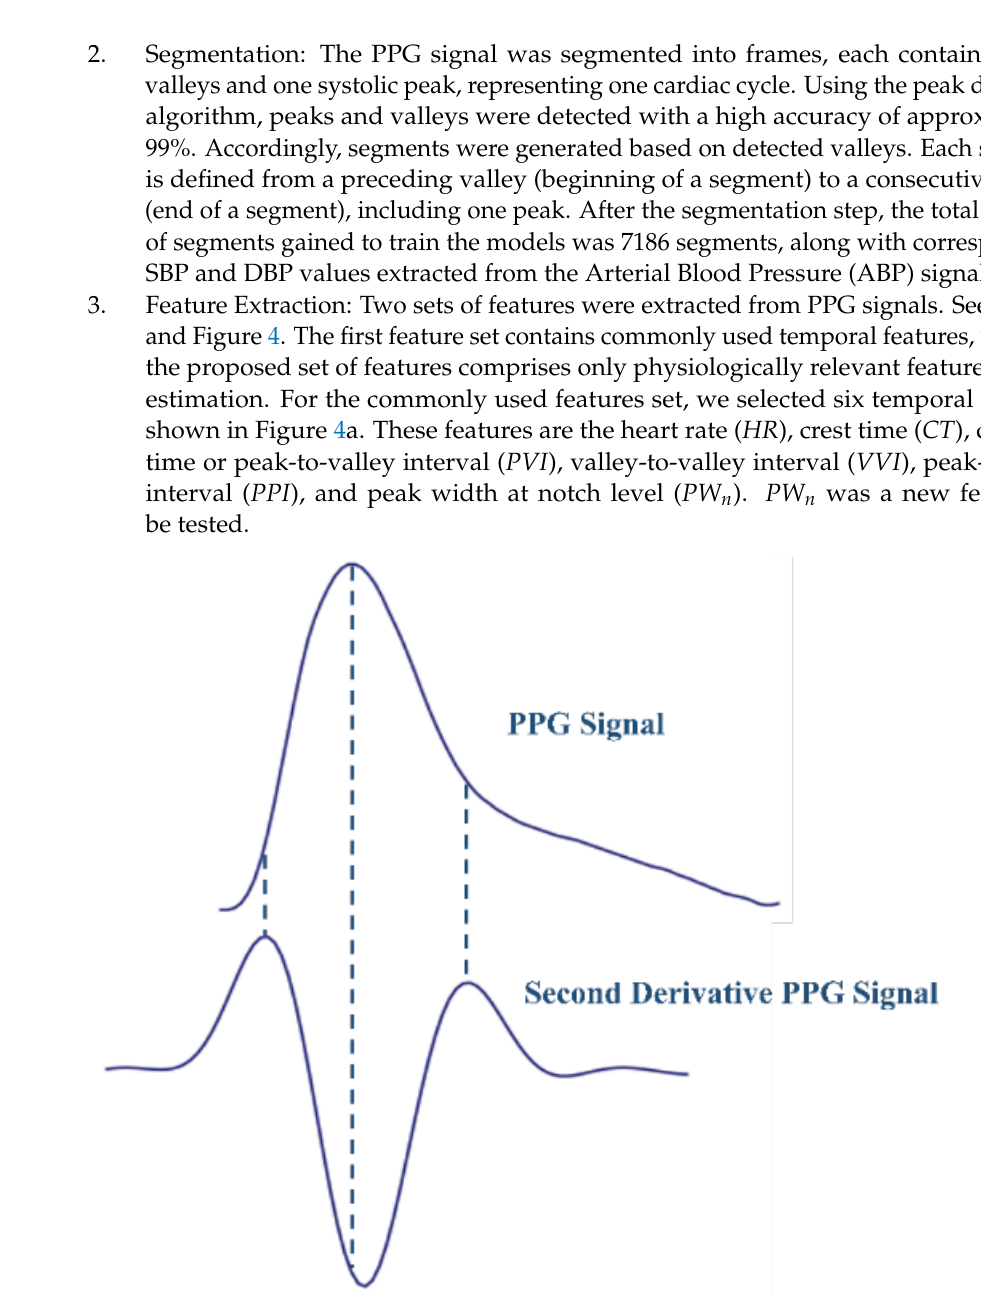
Figure 3. The Acquired PPG Signal and the Filtered Normalized Second Derivative.